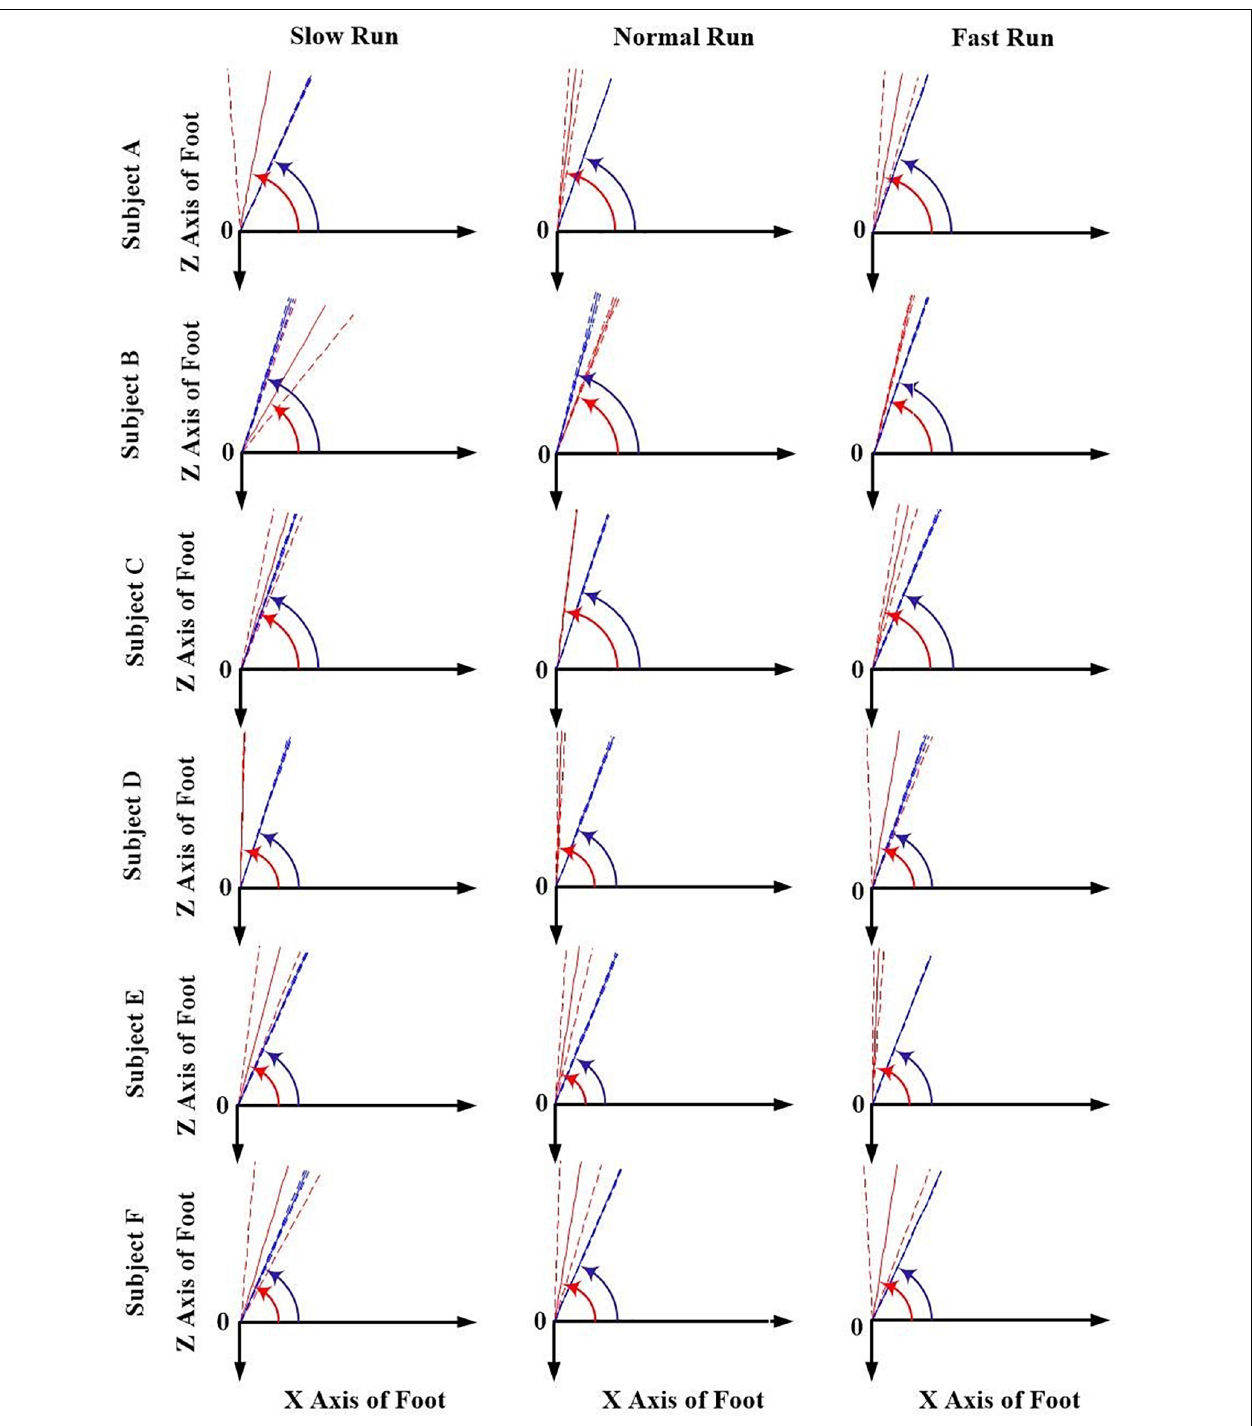
FIGURE 3 | The orientation angle α made by the anatomical axis (blue) and functional axis (red) for all the six subjects (A–F) across all the three speeds of running (slow, normal, fast). Solid lines depict mean; dashed lines depict the 1 SD zones.